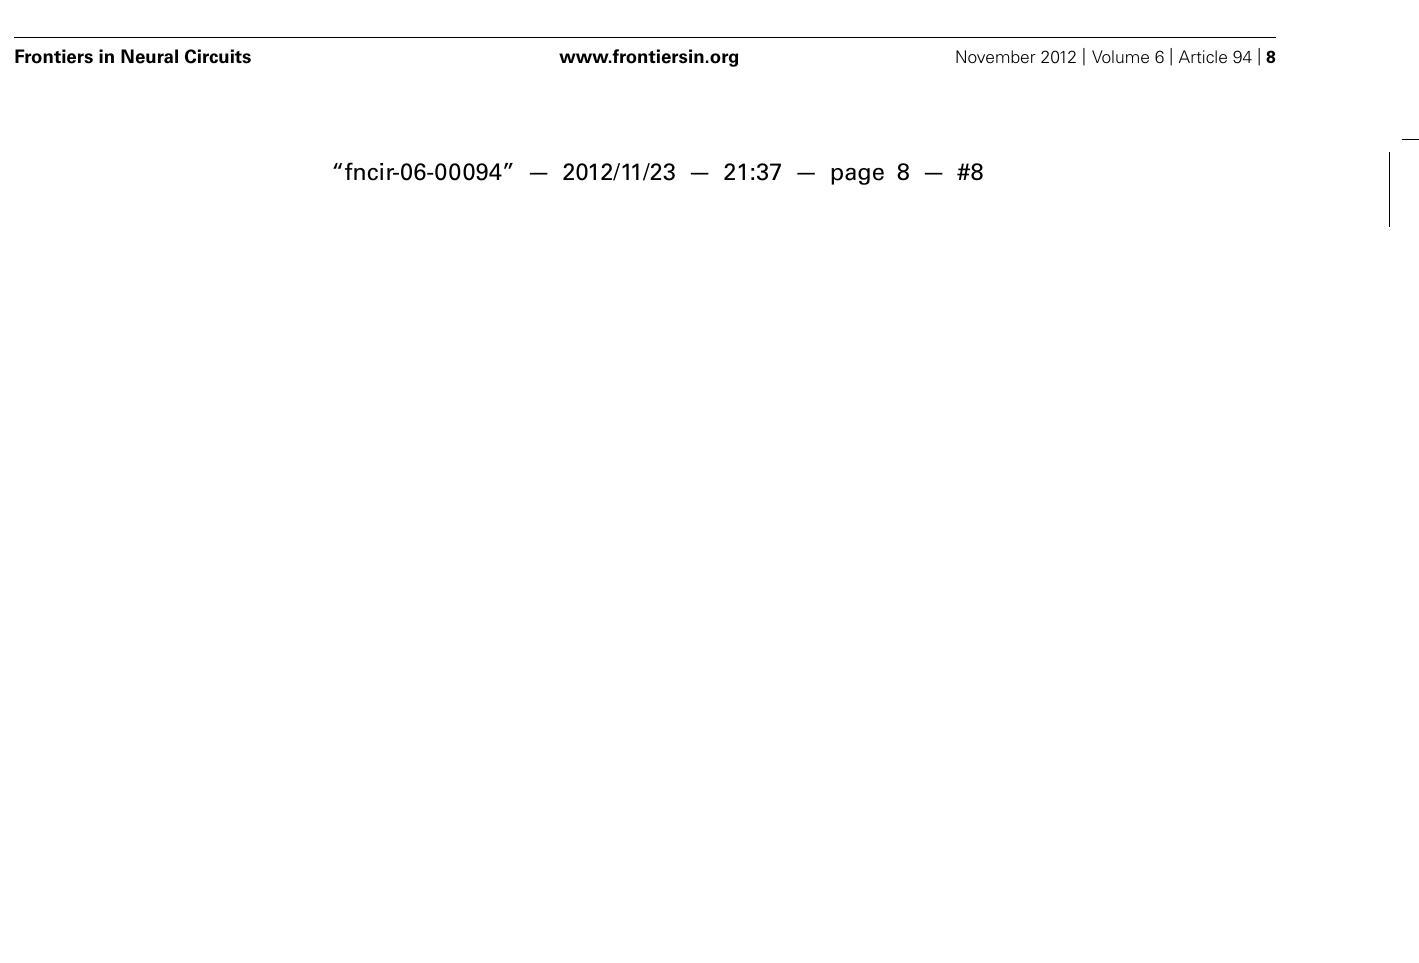
FIGURE 4 | Spike- and exc-ratio time-histograms duringTHDOC reveal the appearance of new states in the network. Data from different time segments (see the gray legends in the middle). Data from excitatory and inhibitory neuron clusters are in black and red, respectively. For each time segment there are one or two plots depending if one (state 1, upper) or two (state 2, lower) states have been identified (see vertical legends at the right border).The percentage of the occupation (PO) of the two states is shown in each plot to the right. Upper panels : Cumulative spike histograms (cFSH).To compare each result (thick lines) obtained in the different time segments, the